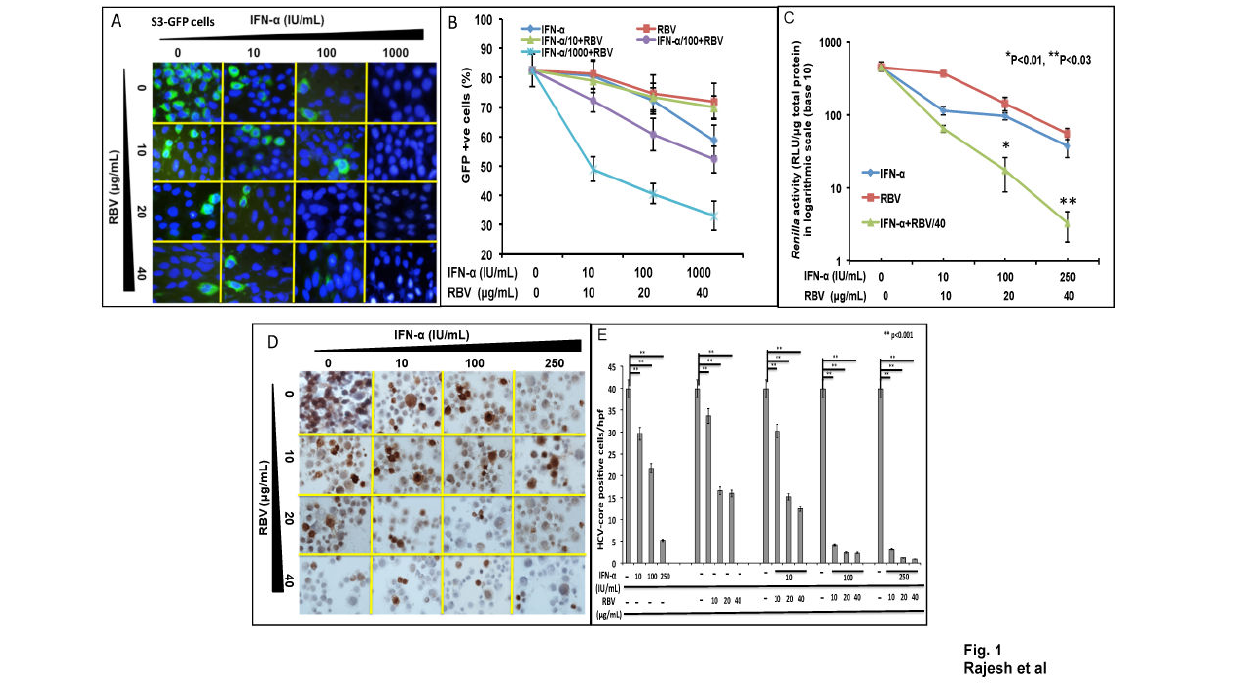
Figure 1. Antiviral effect of IFN-α and RBV combination treatment using a sub-genomic replicon cell line (S3-GFP) and HCV infected Huh-7.5 cells. ( A ) S3-GFP cells were treated with IFN-α and RBV for 72 hours. GFP expression was examined under a fluorescence microscope. ( B ) GFP positive cells were quantified by flow cytometric analysis. ( C ) Infected Huh-7.5 cells were treated with IFN-α alone, RBV alone and combination for 72 hours. Renilla Luciferase activity of infected cells was measured and normalized with 1µg of cellular protein. ( D ) Expression of HCV core protein was measured by immunostaining and ( E ) core positive cells in five different high power fields (hpf) at 40X magnification were counted under a light microscope. Quantitative assessment of the number of HCV positive cells with mean and standard deviation of the combination treatment are